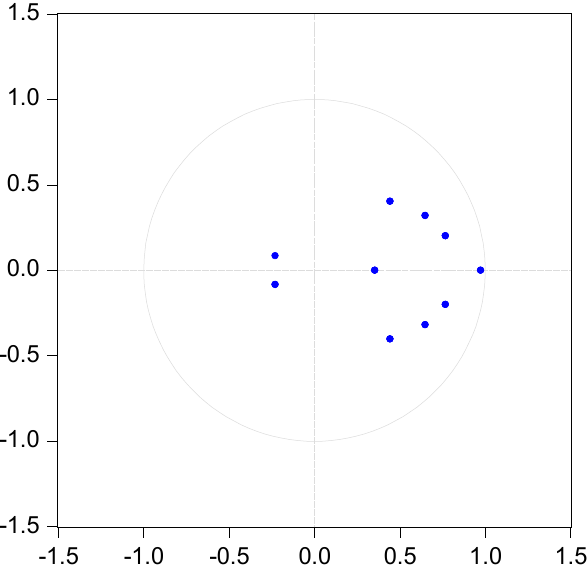
Figure 1. Unit root test, Vector Autoregression model. Source: Author’s calculations; data retrieved from https://fred.stlouisfed.org/series, accessed on 7 June 2021. Table 3. Vector Autoregression Model Estimations, China,